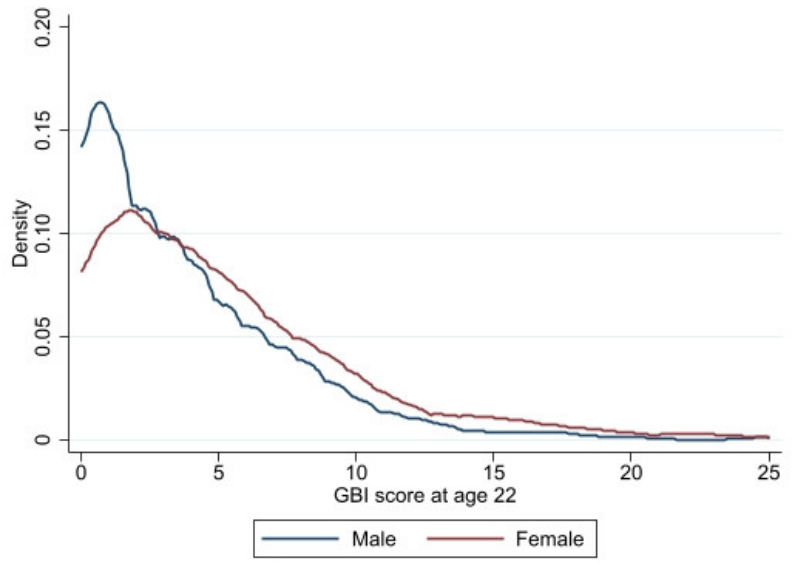
Figure 1. Distribution of the GBI score at age 22 by sex.